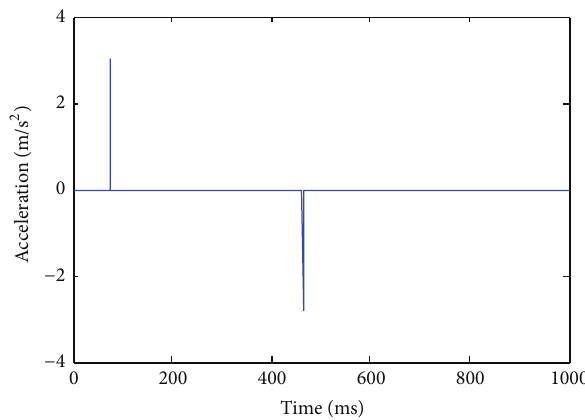
Figure 1: Extracted useful signal from 5dB IMF1 based on “3 𝜎 ”